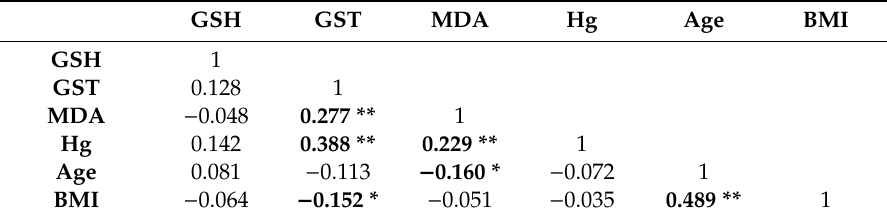
Table 2. Spearman correlations between the evaluated biomarkers, age, and BMI.